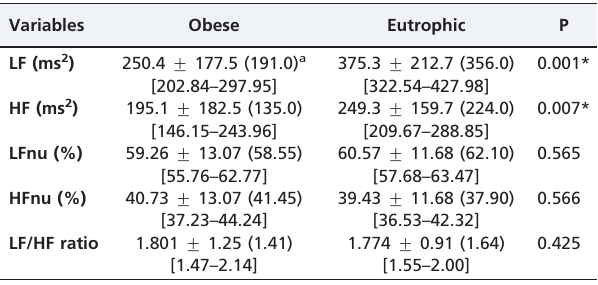
Table 2 - Linear index values of heart rate variability (frequency domain) of obese and eutrophic